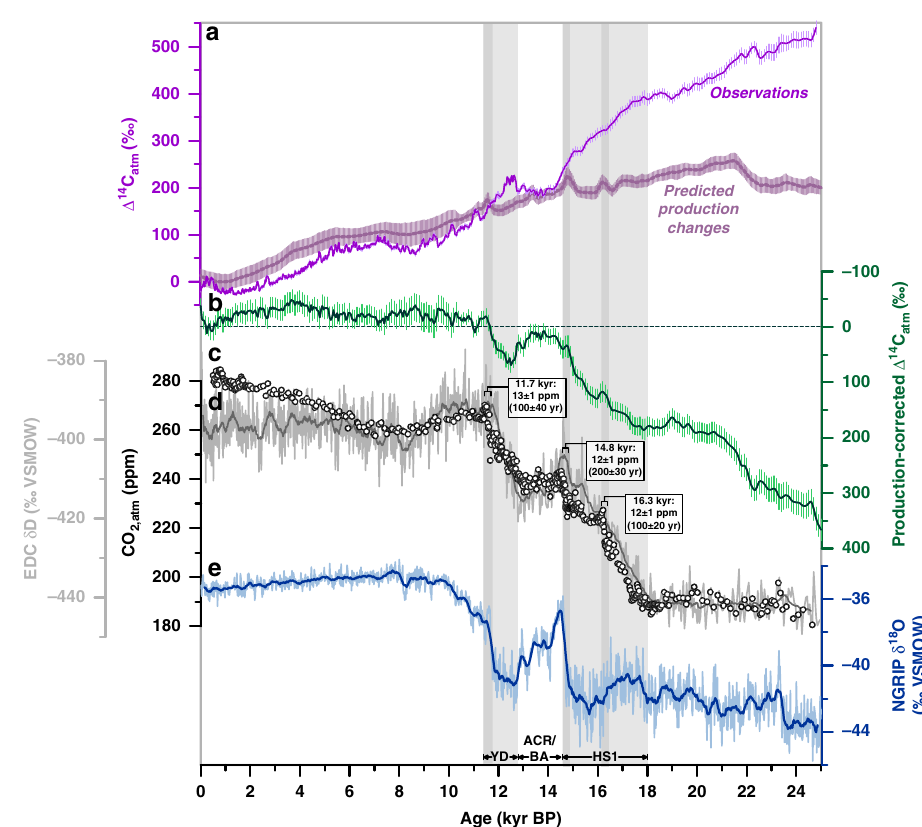
Fig. 1 Deglacial changes in atmospheric carbon dioxide levels. a Atmospheric radiocarbon ( 14 C) concentrations referenced to modern (i.e. 1950) levels ( Δ 14 C atm , ShCal13, error bars show 1 σ -standard deviations (SD)) 26 compared to predicted (i.e. modelled) 14 C changes in the atmosphere due to variations in cosmogenic production 3 (with error bars showing 1 σ -SD), b production-corrected 3 variations in Δ 14 C atm , with error bars showing 1 σ -SD, c atmospheric CO 2 (CO 2,atm ) variations 32 , and d Antarctic temperature variations represented by water isotope changes, δ D, in the Antarctic EPICA Dome C (EDC) ice core 25 , and e water isotope changes, δ 18 O, in Greenland ice core NGRIP 74 . Vertical bars indicate intervals of rising CO 2,atm levels. Darker bars highlight intervals of rapidly rising CO 2,atm concentrations at ~11.7, ~14.8, and ~16.3 kyr before present (BP) 32 . HS1 Heinrich Stadial 1, ACR Antarctic Cold Reversal, BA Bølling Allerød, YD Younger